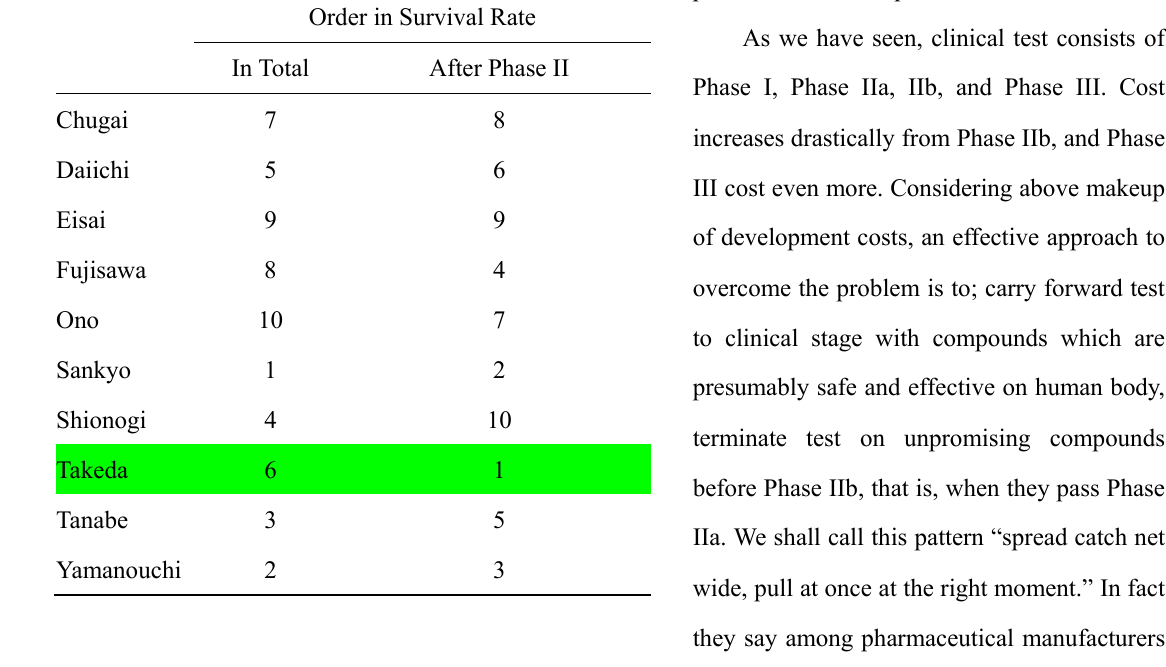
Table 2. Comparison of Survival Rate Order in Survival Rate In Total After Phase